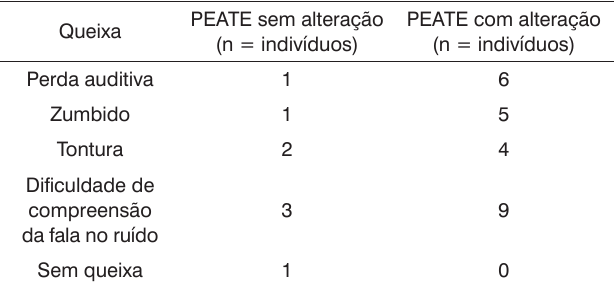
Tabela 7. Relação entre as queixas auditivas e o resultado dos potenciais evocados auditivos de tronco encefálico.